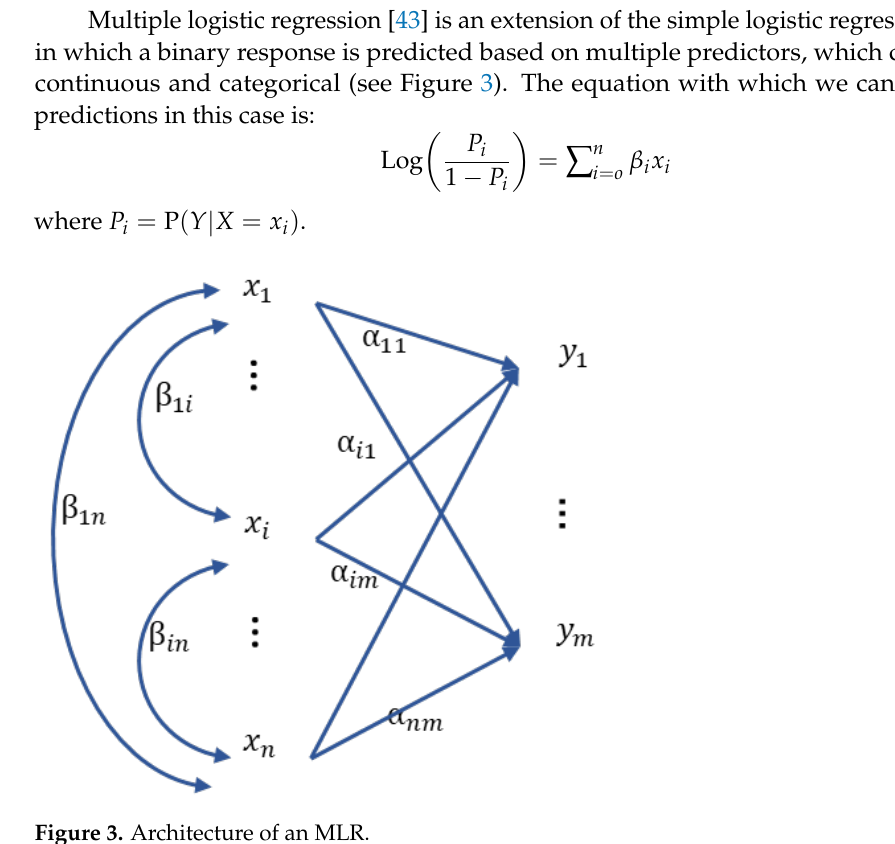
Figure 3. Architecture of an MLR.